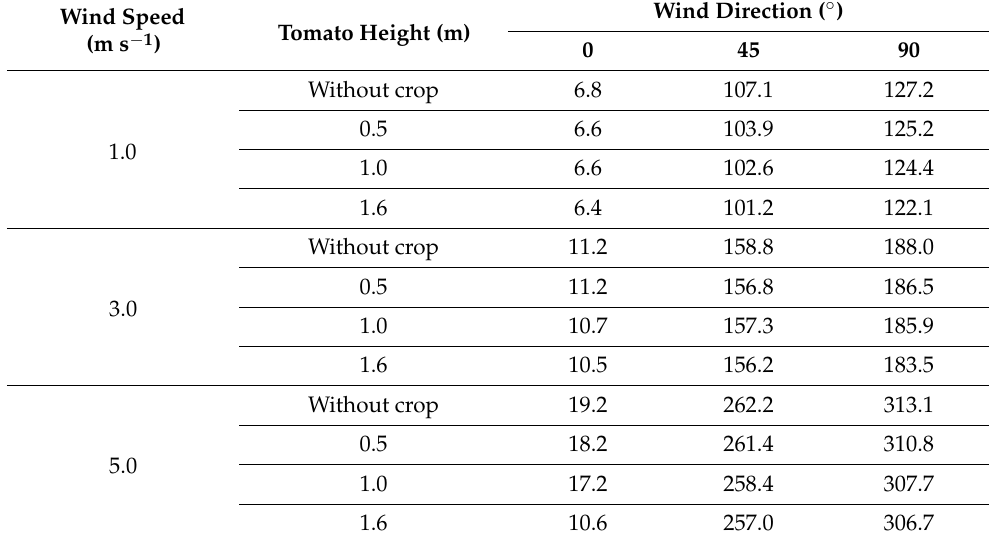
Table 7. Ventilation rate (ACH) of the wide-span greenhouse according to WD, WS, and tomato plant